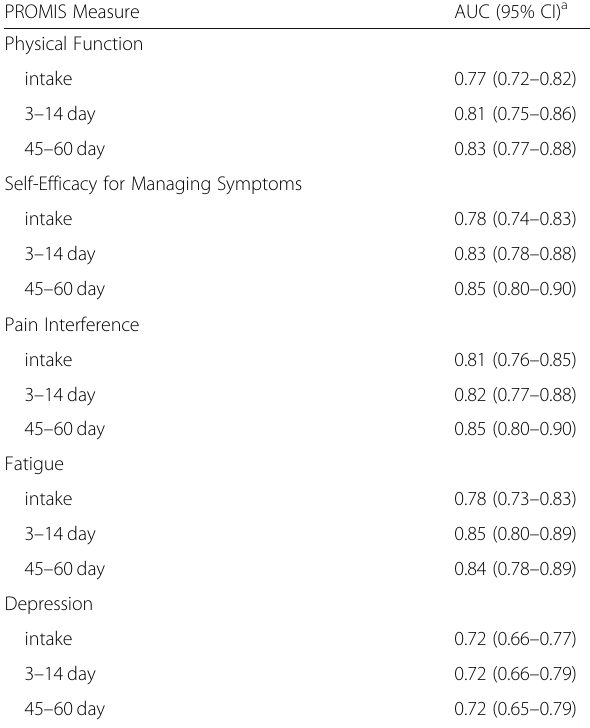
Table 2 Receiver operator curve analysis for intake ( n = 360), 3 – 14 day follow-up ( n = 230), and 45 – 60 day follow-up ( n = 227) PROMIS Measure